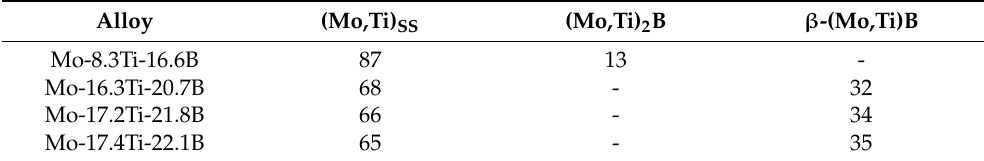
Table 1. Volume fractions of the present phases in the as-cast Mo-Ti-B alloys in vol.%, determined by Rietvled